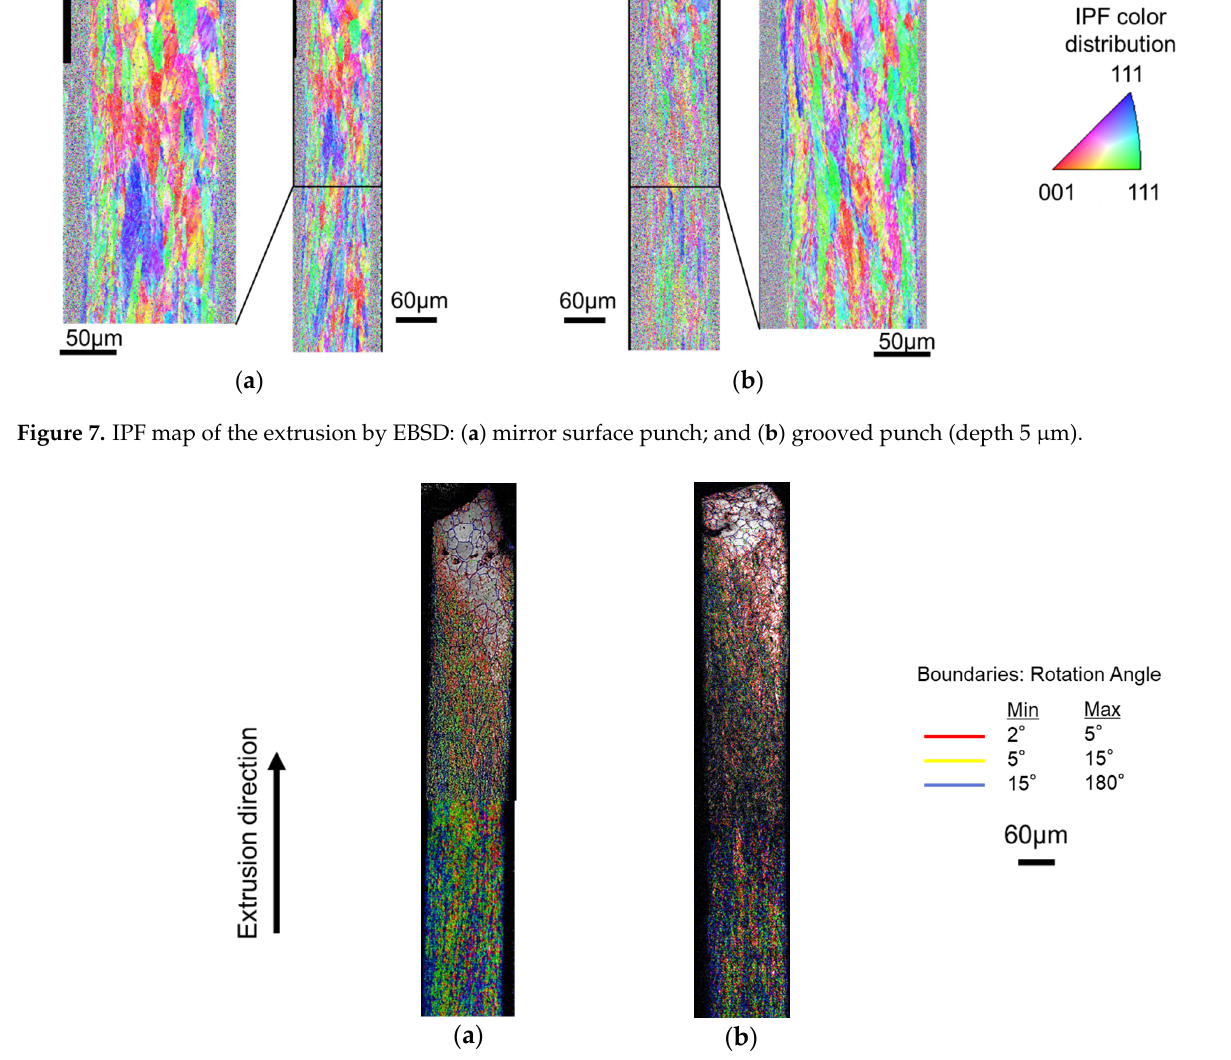
Figure 8. IQ map of the extrusion by EBSD: ( a ) mirror surface punch; and ( b ) grooved punch (depth 5 µm).